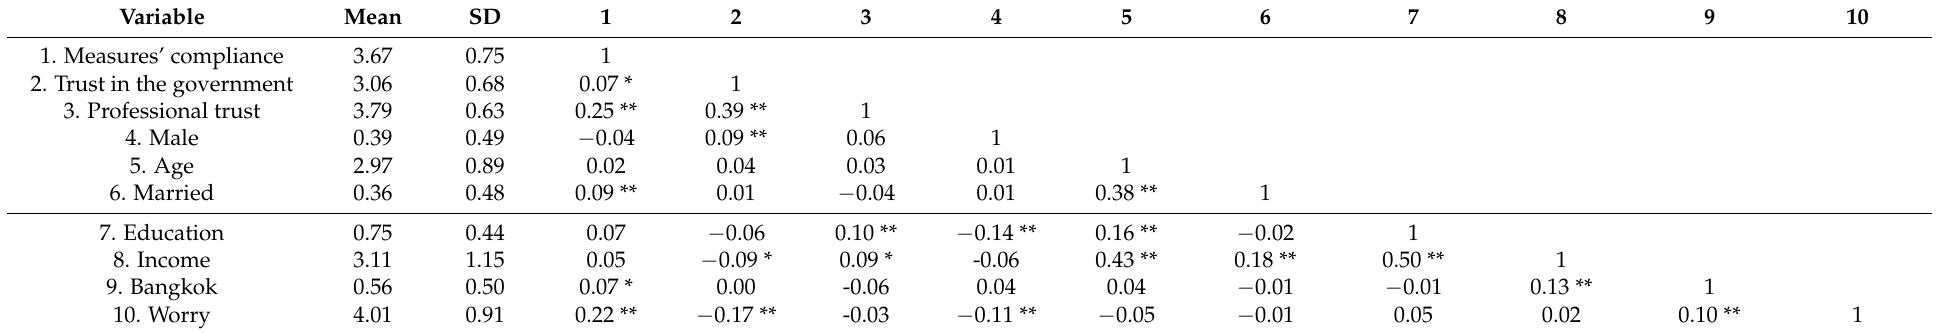
Table 3. Descriptive statistics and Pearson correlation